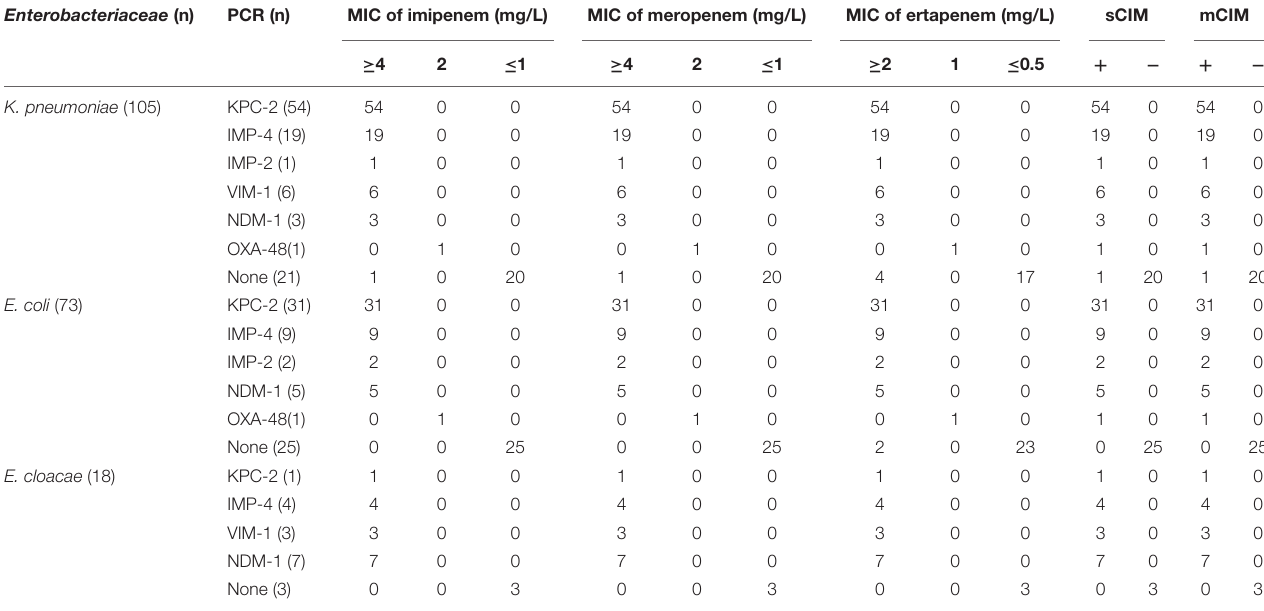
TABLE 2 | Laboratory detection of 196 Enterobacteriaceae isolates.